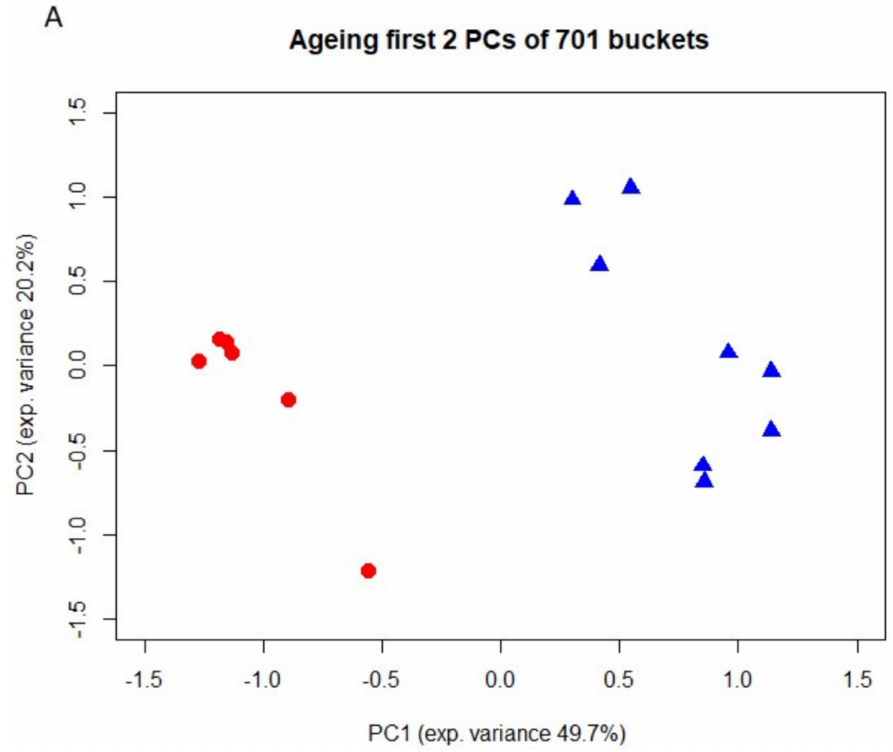
Figure 2. Targeted profiling of urine metabolites of 3- and 24-month-old rats by NMR spectroscopy. All concentrations were normalized to creatinine [ µ mol/mmol]. p -values were determined by a two-sided Welch t -test. To account for multiple testing the false discovery rate was controlled at the 5% level. For all figures p -values ≤ 0.05, ≤ 0.01, and ≤ 0.001 are indicated by one, two or three asterisks,